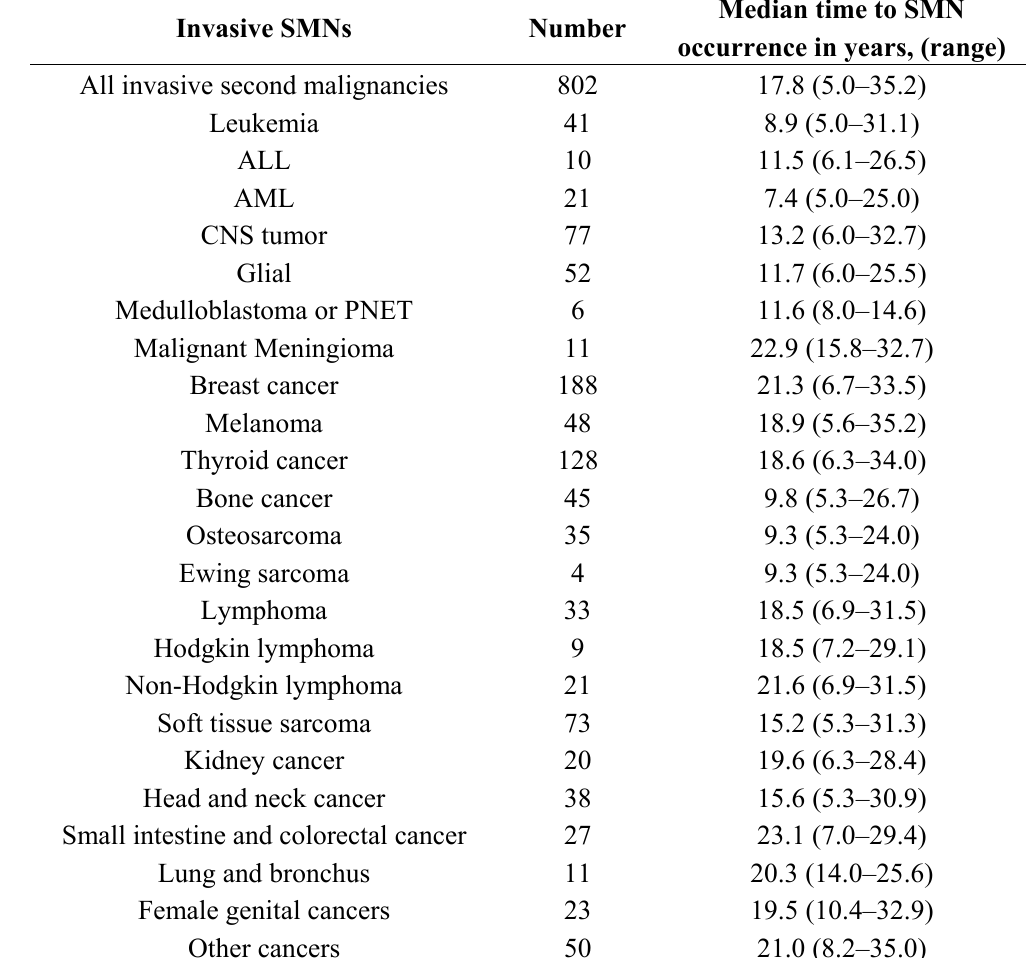
Table 2. Invasive second malignant neoplasms (SMNs) according to the latest Childhood Cancer Survivor Study (adapted from Reference [26] with author